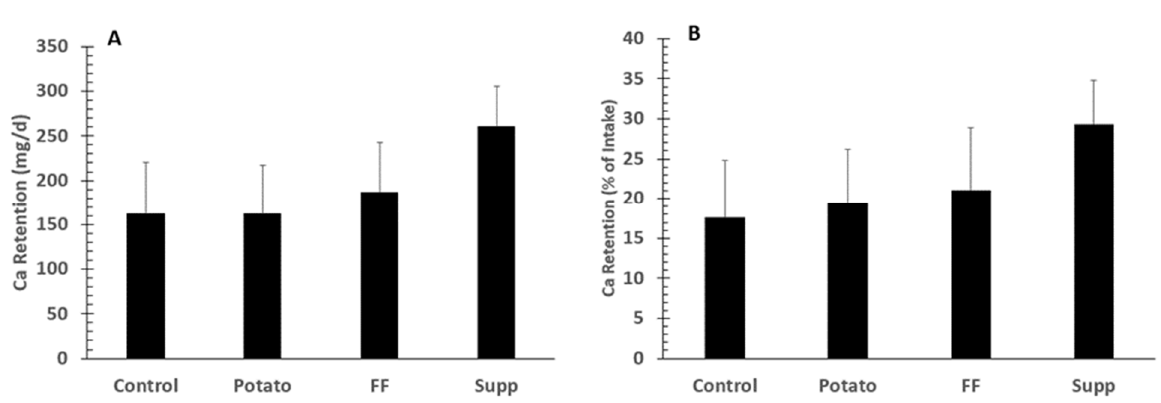
Figure 3. Means ± SE of calcium retention ( n = 20) as absolute calcium (Ca) retention ( A ) or percent (%) of intake ( B ) in adults fed controlled diets of lower (control) and higher potassium as potato, French fries (FF), or K gluconate (Supp). There were no significant group differences among groups by